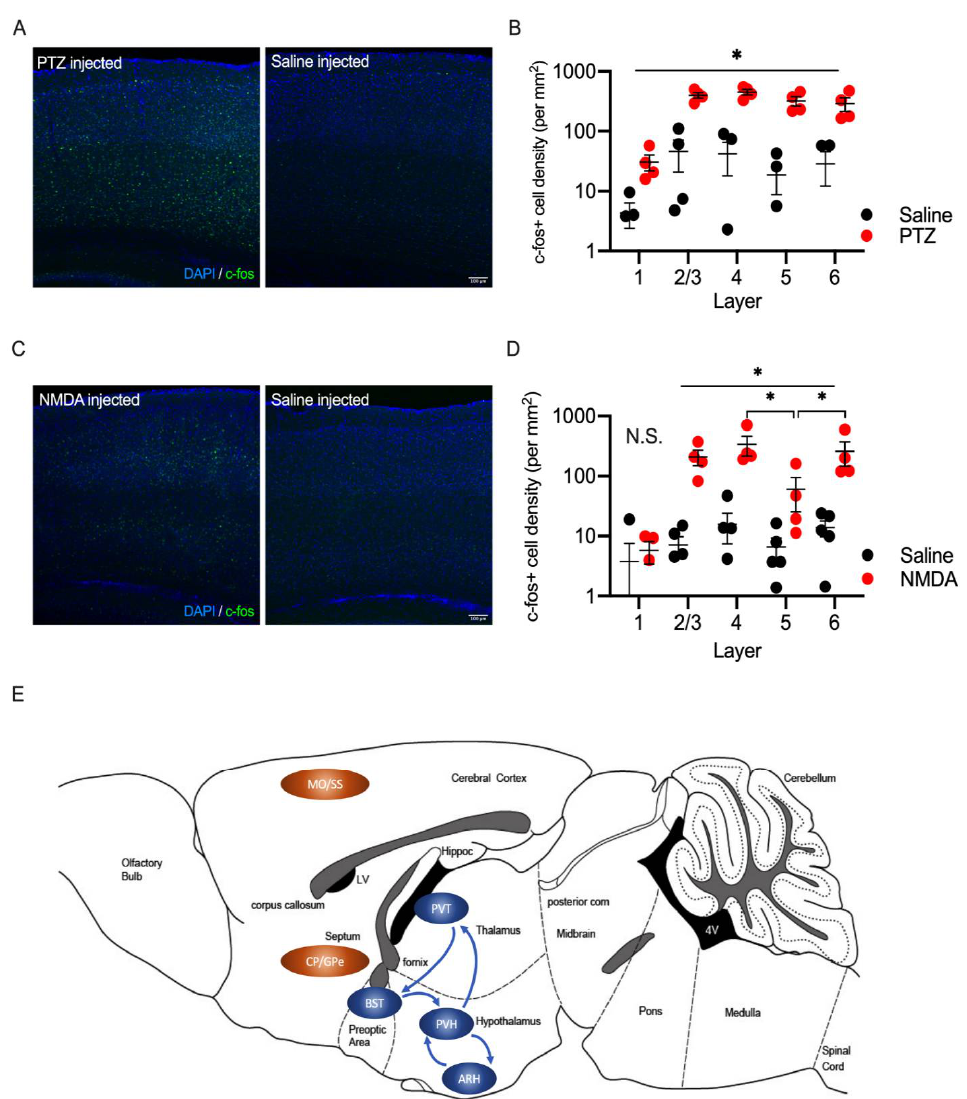
Figure 7. Laminar distribution of c-fos expression after PTZ or NMDA injection in wild-type mice. ( A ) Representative images for c-fos (green) immunostaining in the somatosensory region of wild-type mice after PTZ (left) or saline (right) injection. Scale bar = 100 µ m. ( B ) Summary graph for layer distribution of c-fos positive neurons in wild-type mice after PTZ or saline injection. ( C ) Representative images for c-fos immunostaining in the somatosensory region of wild-type mice after NMDA or saline injection. Scale bar = 100 µ m. ( D ) Summary graph for layer distribution of c-fos positive neurons in wild-type mice after NMDA or saline injection. No significant difference was detected in layer 1. The density of c-fos positive cells was increased in the other cortical layers. The density of c-fos cells in NMDA-injected mice was smaller in layer 5 than in layers 4 and 6. ( E ) Activated brain regions after NMDA injection are summarized in a cartoon. Sensorimotor regions are indi-